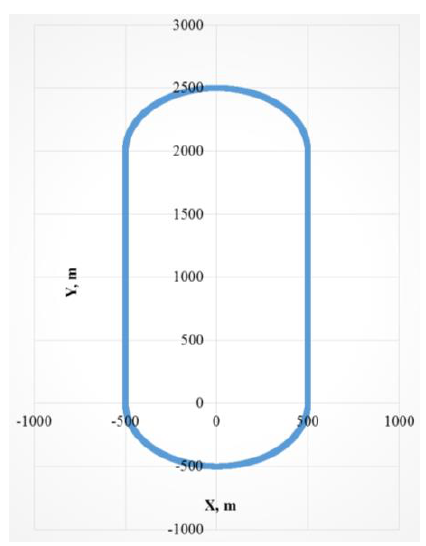
Figure 3. Closed route along linear object